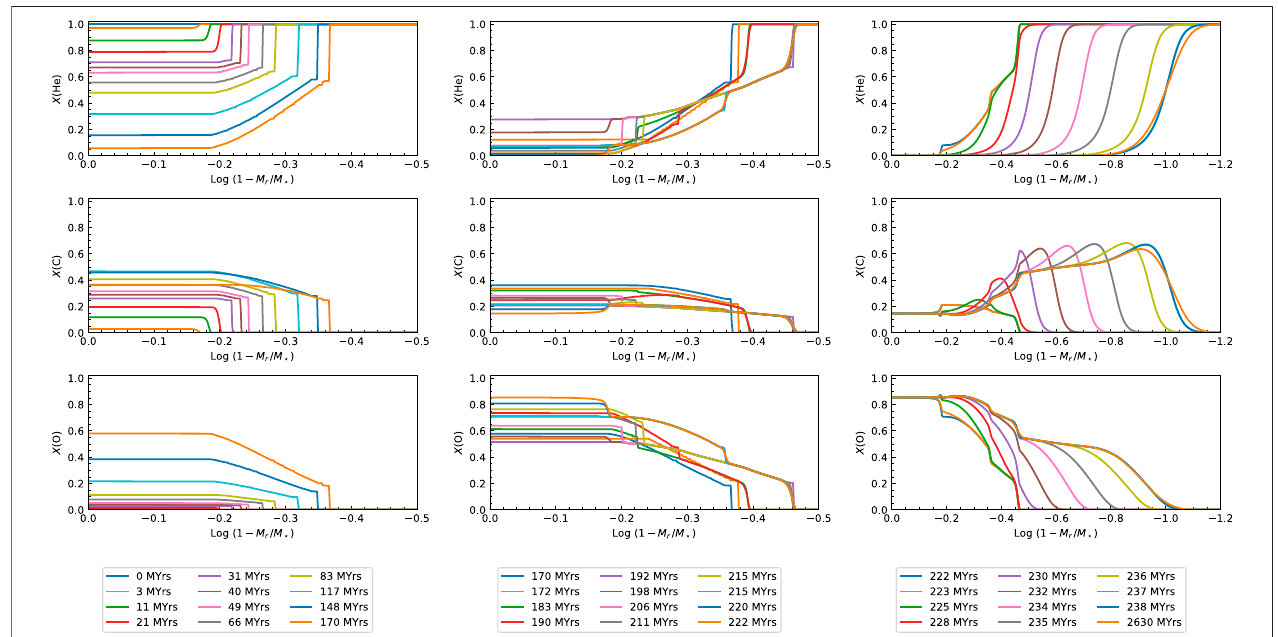
FIGURE14| Evolutionofthehelium,carbon,andoxygenmassfractionpro fi les,fromtheonsetofheliumburninginthecoretothewhite-dwarfcoolingstage,inour reference evolutionarymodel. Left panel shows the growth of the helium burningcore until the fi rst breathing pulse. Middle panel shows the pro fi les evolving during third stage of the helium-burning core that experiences three breathing pulses before complete exhaustion of helium at the center. For completeness, right panel shows the chemicaldistributionthatbuildsupduringtheshellhelium-burningandwhitedwarfcoolingphases.Thelastmodelrepresentedinthispanelcorrespondstoawhite dwarf that has cooled down to ~ 8500